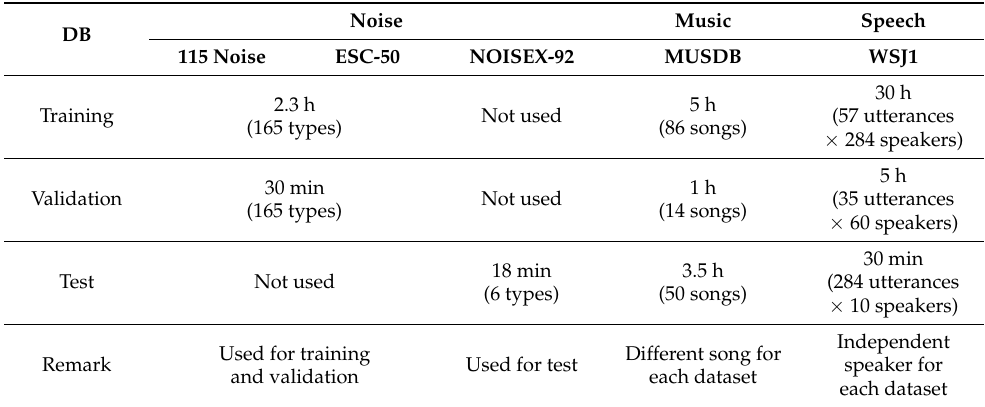
Table 2. Dataset configuration for speech